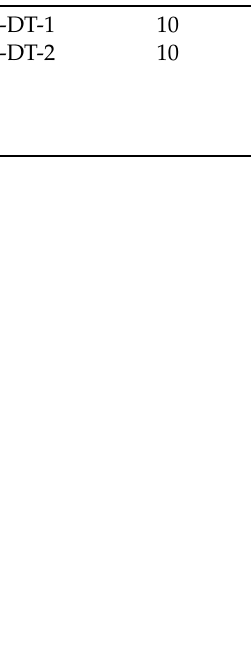
Table A7. Expressions of the bike crank use case in the Terminal